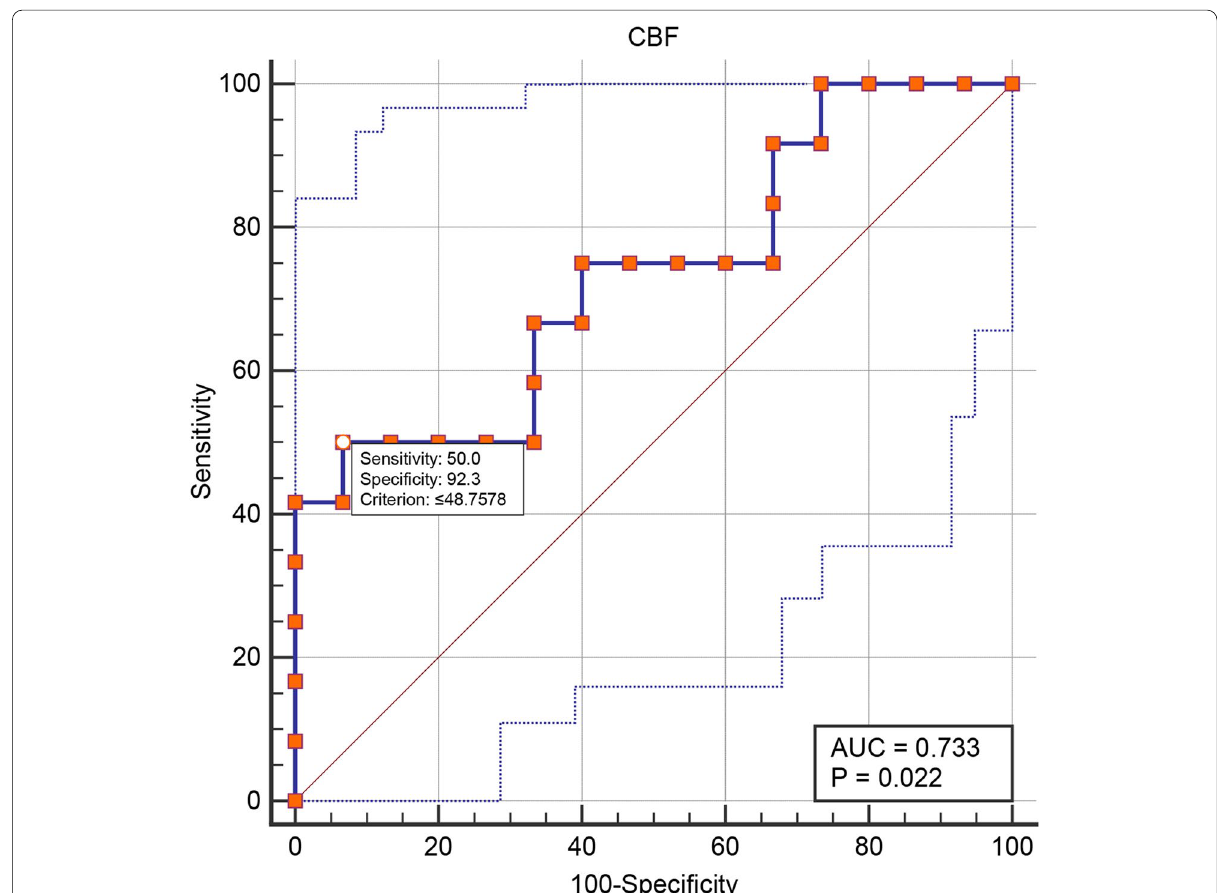
Fig. 3 ROC curve for the CBF value of the left NAcc to diagnose CM from NC. The area under the curve was 0.73 with the cut-off value was 48.76 ml/100